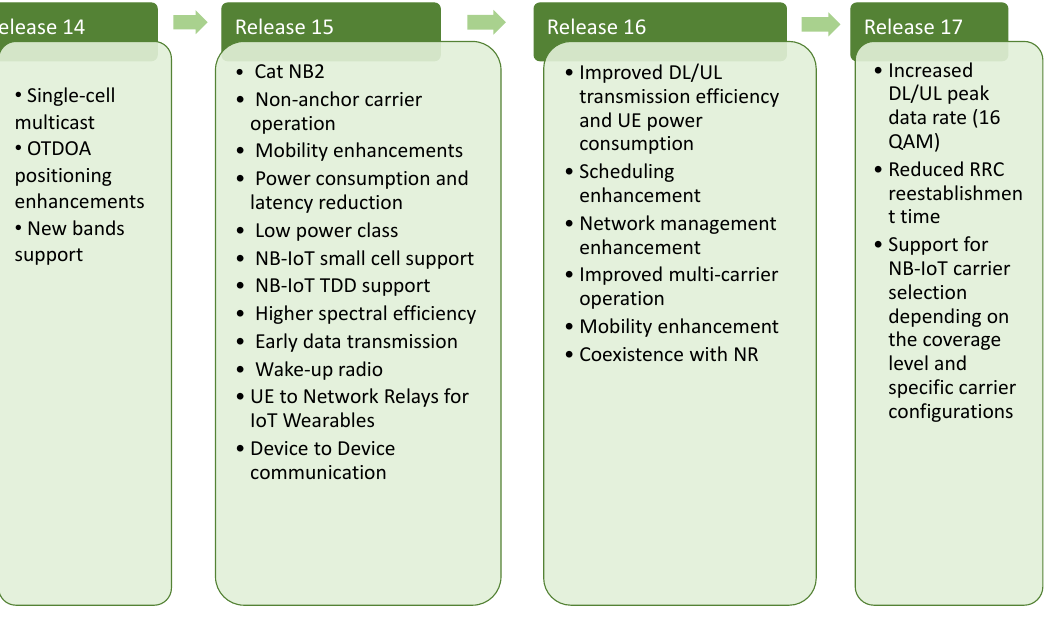
Figure 3. NB -IoT